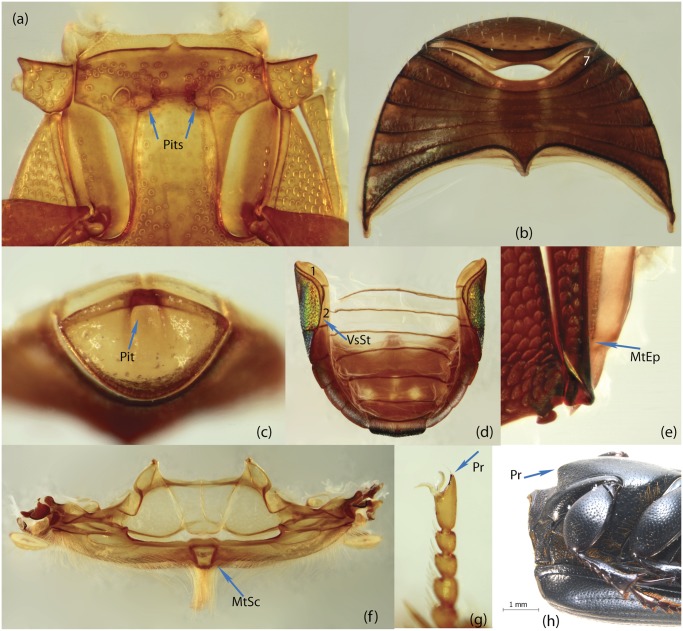
Morphological structures of Scarabaeinae.a, Zonocopris gibbicollis; b, Onthophagus vinctus Erichson, 1843; c, Endroedyolus paradoxus; d, Gymnopleurus leei; e, Aphengium cupreum; f, Coprophanaeus telamon; g, Zonocopris gibbicollis; h, Onthophagus muticifrons Endrödi, 1973 a, pterothorax, ventral view; b, abdomen, ventral view; c, pygidium; d, abdomen, dorsal view; e, apex of metepisternum, lateral view; f, metanotum; g, mesotarsus; h, pterothorax, lateral view.